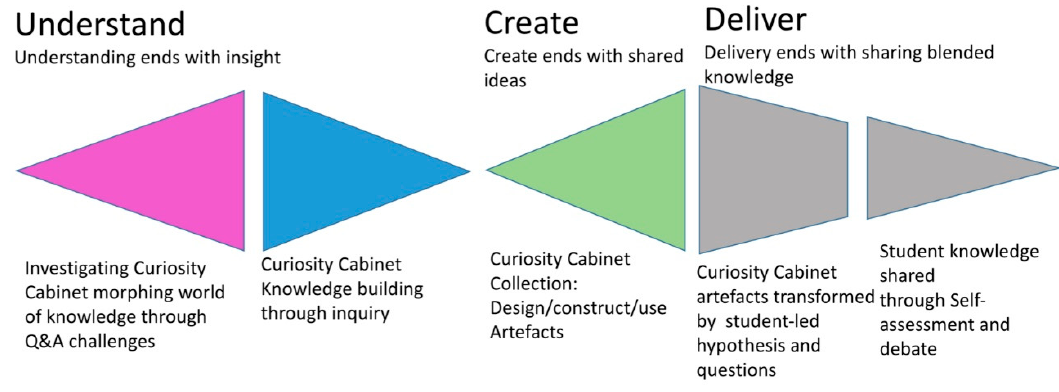
Figure 1. Curiosity cabinet metaphor context as a design thinking process.